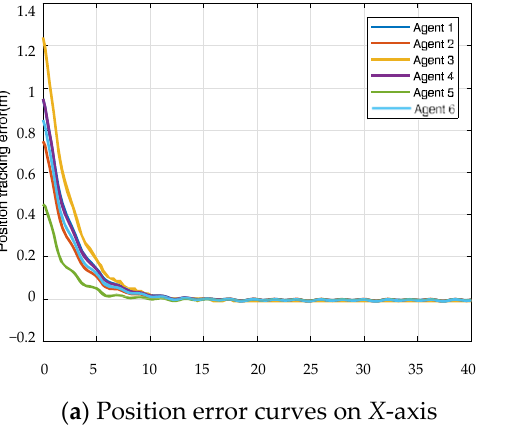
( b ) Position error curves on Y -axis